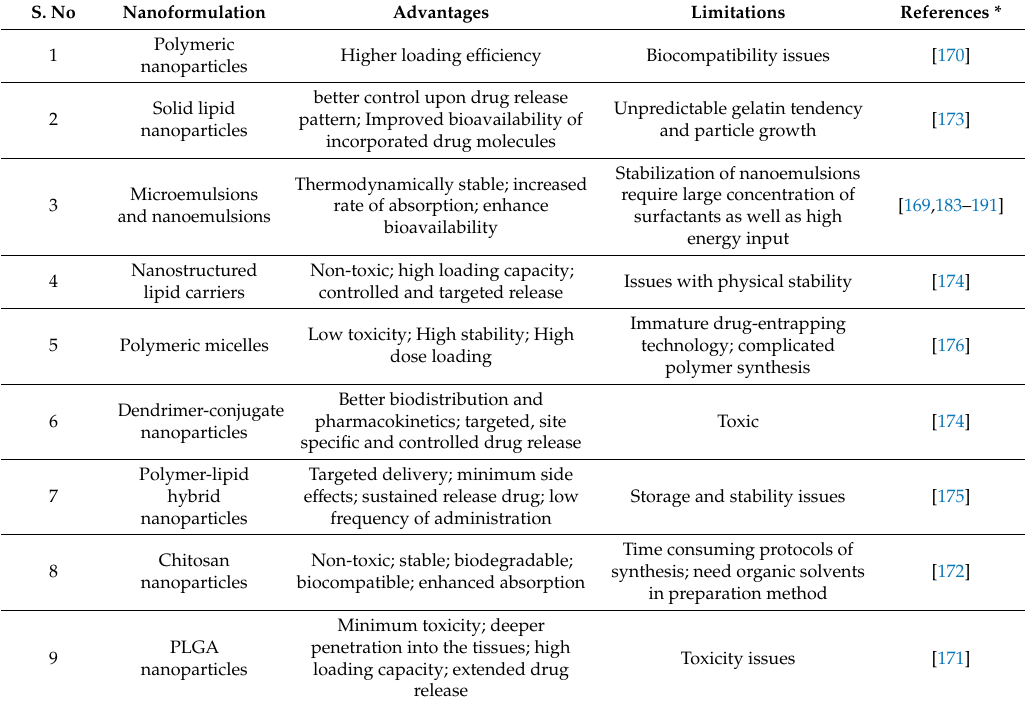
Table 2. List of nanoformulations for intranasal drug delivery, with their potential advantages and